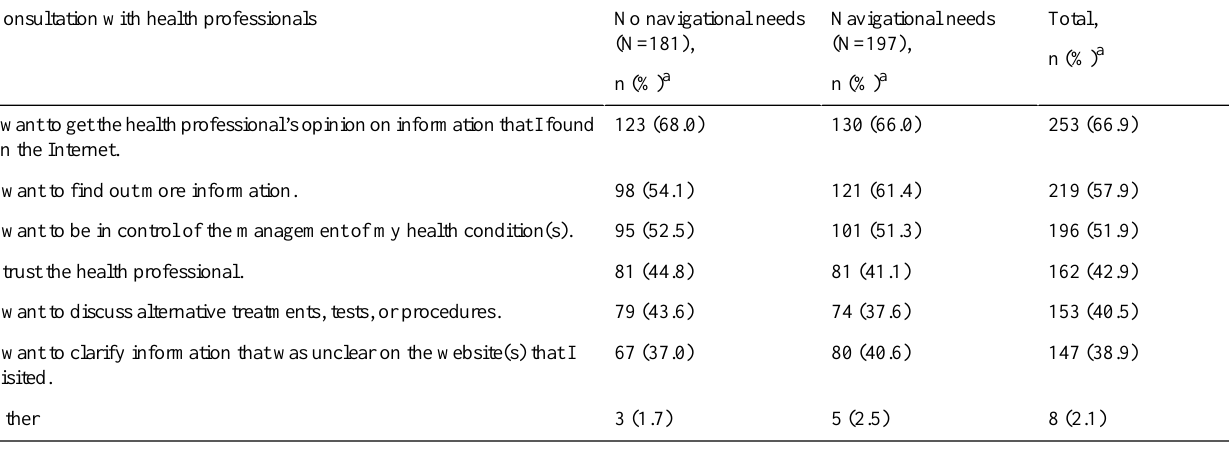
Navigational needs (N=197), n (%) a